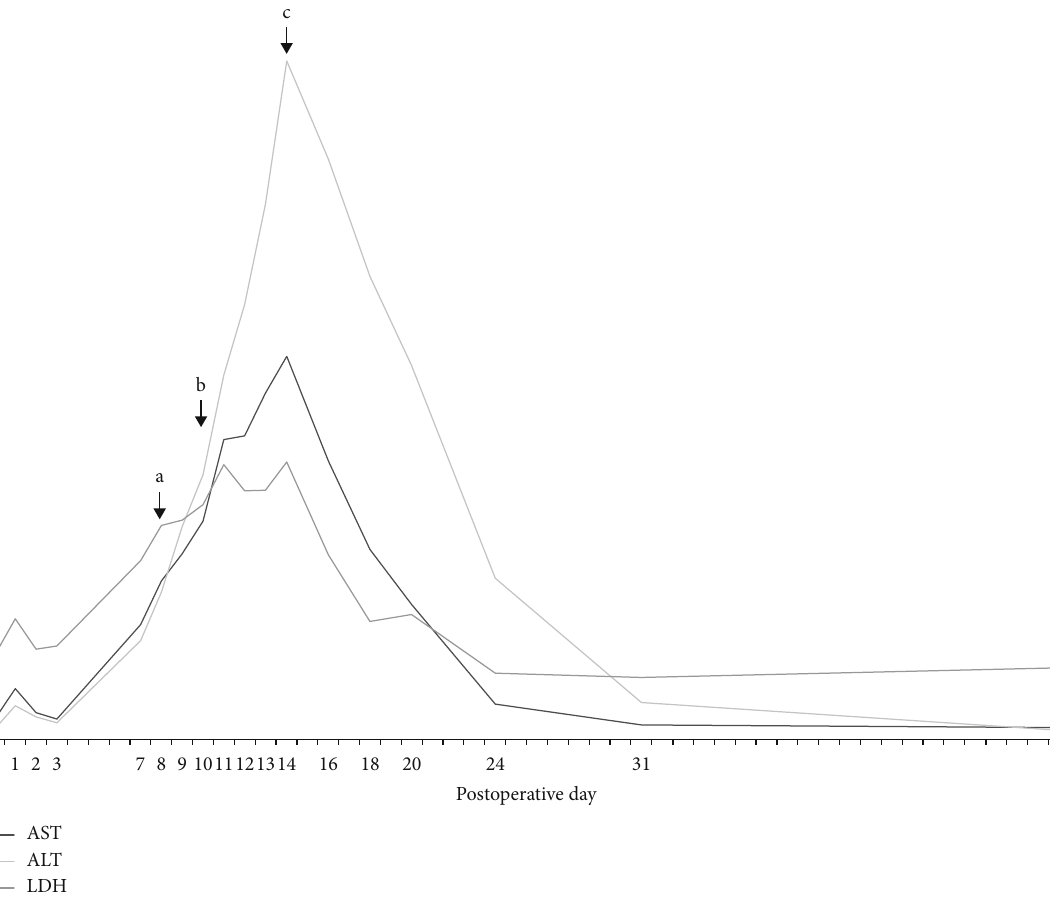
Figure 4: Temporal changes in serum levels of aspartate transaminase (AST), alanine transaminase (ALT), and lactate dehydrogenase (LDH). (a) all drugs, except for immunosuppressant drug and acetaminophen, were stopped. (b) Liver biopsy was performed. (c) The use of per- request medication (acetaminophen) was